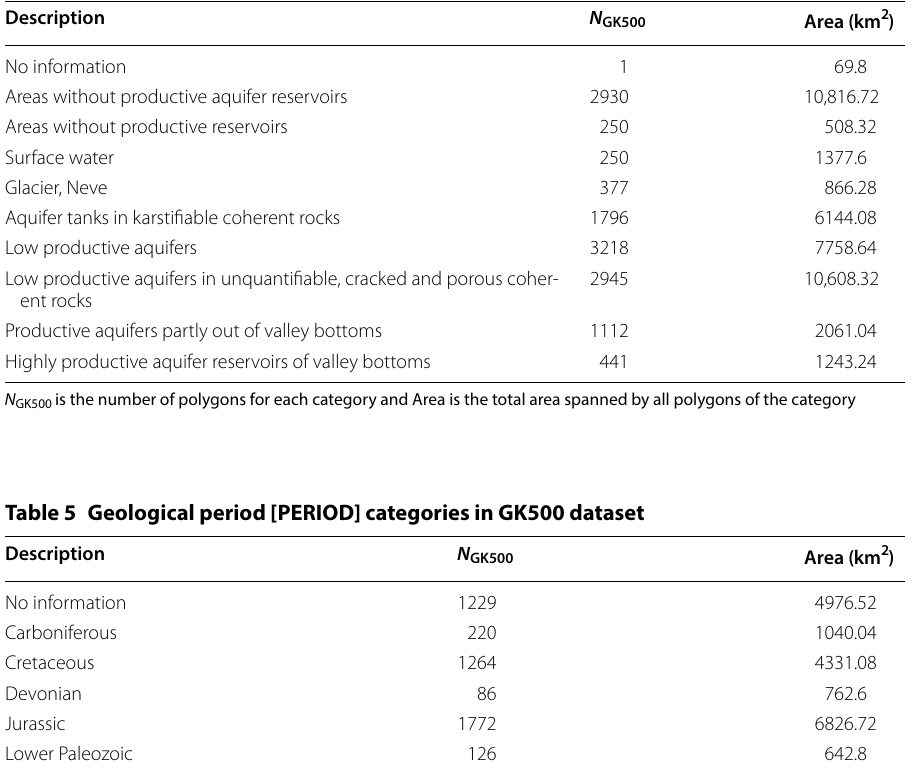
Table 4 Hydrogeology [HYDRO] categories in GK500 dataset